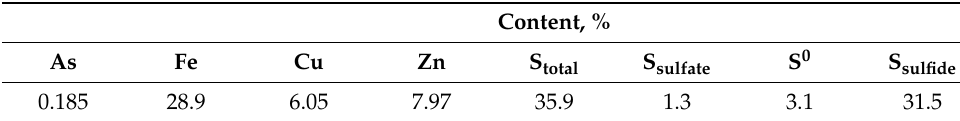
Table 2. Main element content in ASL